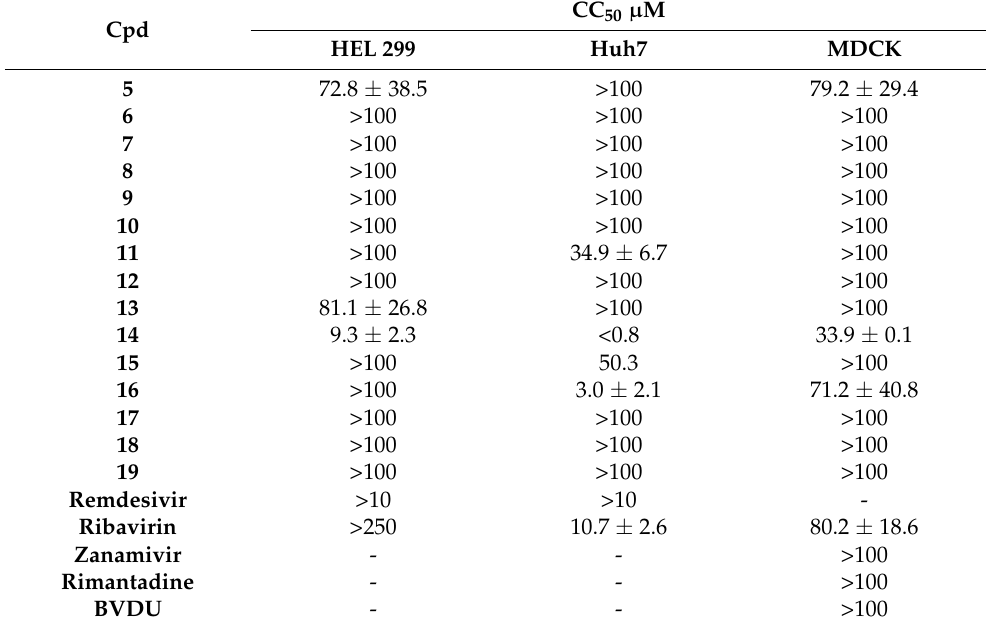
Table 4. Cytotoxicity in the virus host cell lines.